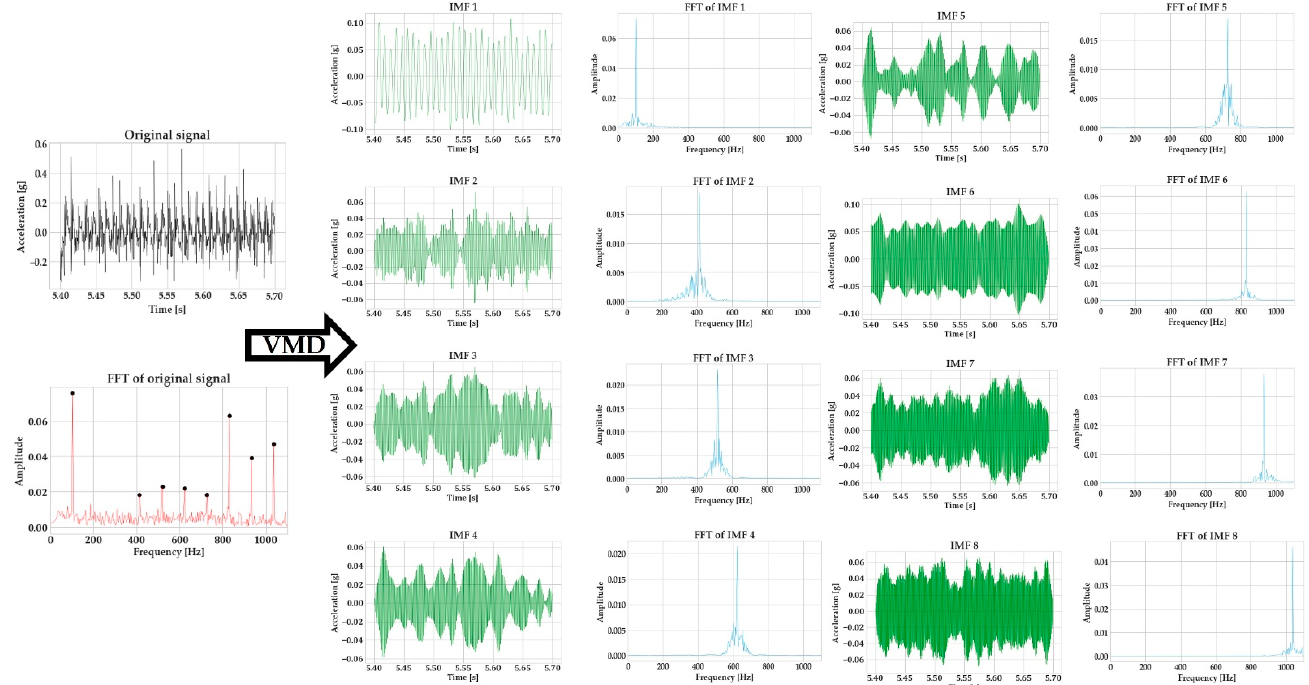
Figure 10. Decomposition of the milling vibration signal generated by the Micromega sensor with VMD.